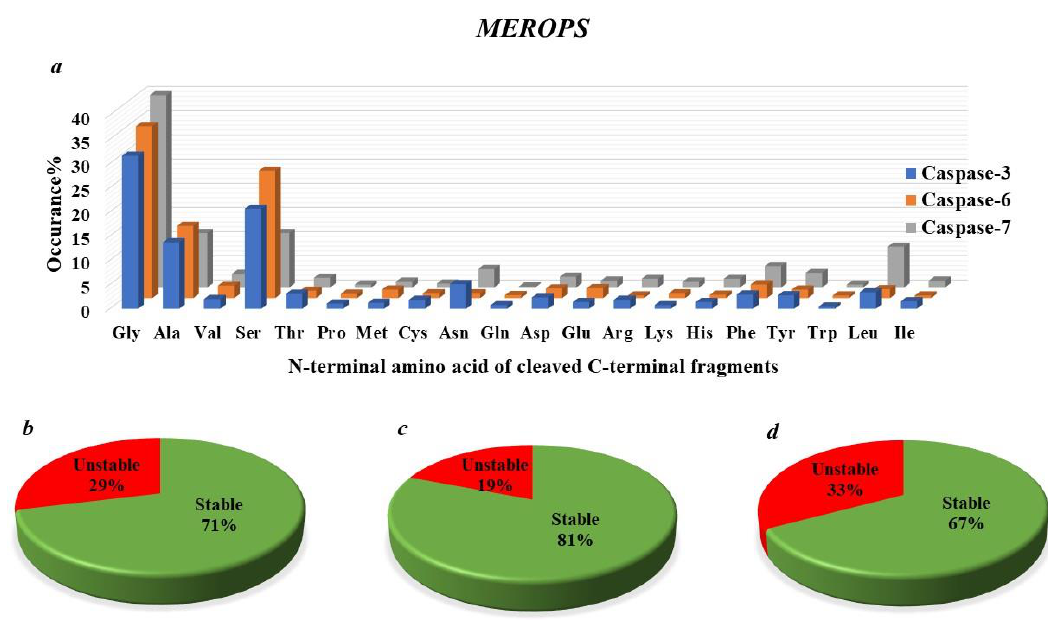
Figure 4. Distinct groups of proteolytic C-terminal fragments based on bearing different N-terminal amino acid residues within the database MEROPS and their occurrence % as indicated in MEROPS database ( a ); ( b ) Quantification of % of occurrence of destabilizing and stabilizing fragments generated by caspase-3 cleavage based on their theoretical half-lives; ( c ) Quantification of % of occurrence of destabilizing and stabilizing fragments generated by caspase-6 cleavage based on their theoretical half-lives; ( d ) Quantification of % of occurrence of destabilizing and stabilizing fragments generated by caspase-7 cleavage based on their theoretical half-lives.